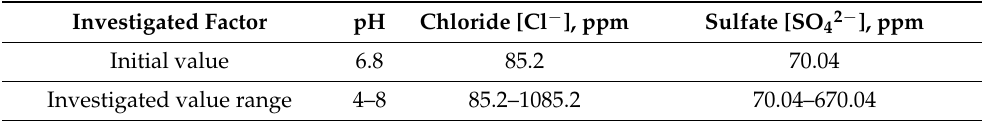
Table 1. Initial concentrations and investigated value range of factors in synthetic soil solution